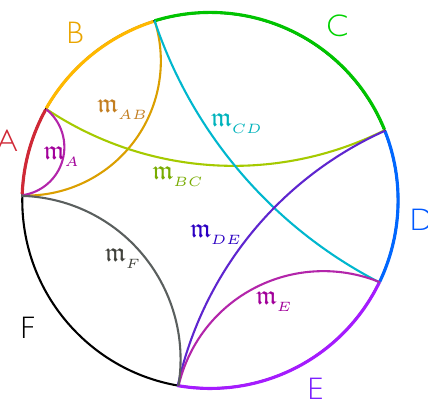
Figure 10 . Analogous to (cid:12)gure 1: an example of partitioning of the boundary space into six regions A , B , C , D , E , and the complement F (cid:17) ABCDE , as labeled. The corresponding minimal surfaces for AB , BC , CD , DE , and EA are also indicated. The AC minimal surface assumes